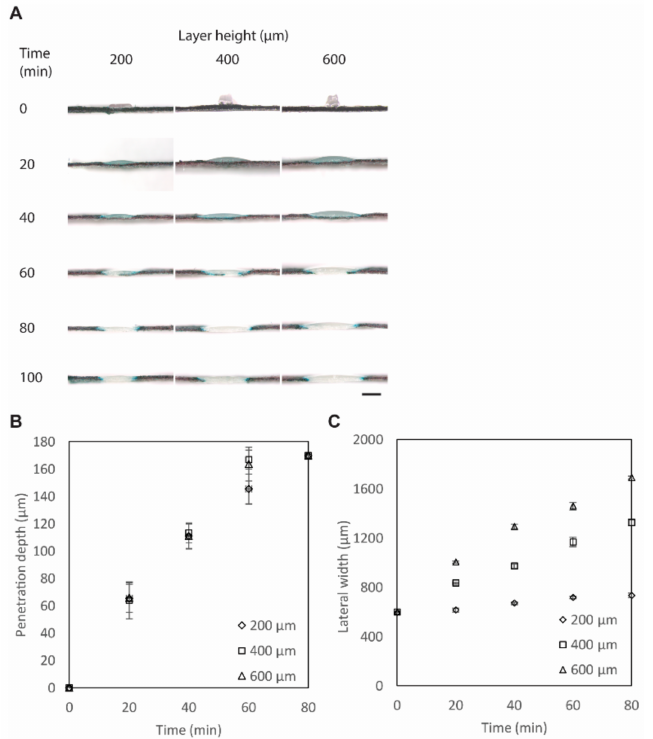
Figure 2. Penetration of PCL through the filter paper. ( A ) Optical micrographs of the cross-sections of the filter paper printed with PCL. The paper was dyed with black ink to highlight the location of the penetrated polymers. Scale bar = 800 µ m. ( B ) Plot showing the penetrated height of PCL ( H ) ( H PCL = 200, 400, and 600 µ m) heated at 150 ◦ C at different timpoints (n = 4). ( C ) Plot showing the lateral widths of PCL ( W ) ( H PCL = 200, 400, and 600 µ m) heated at 150 ◦ C at different timepoints (n =